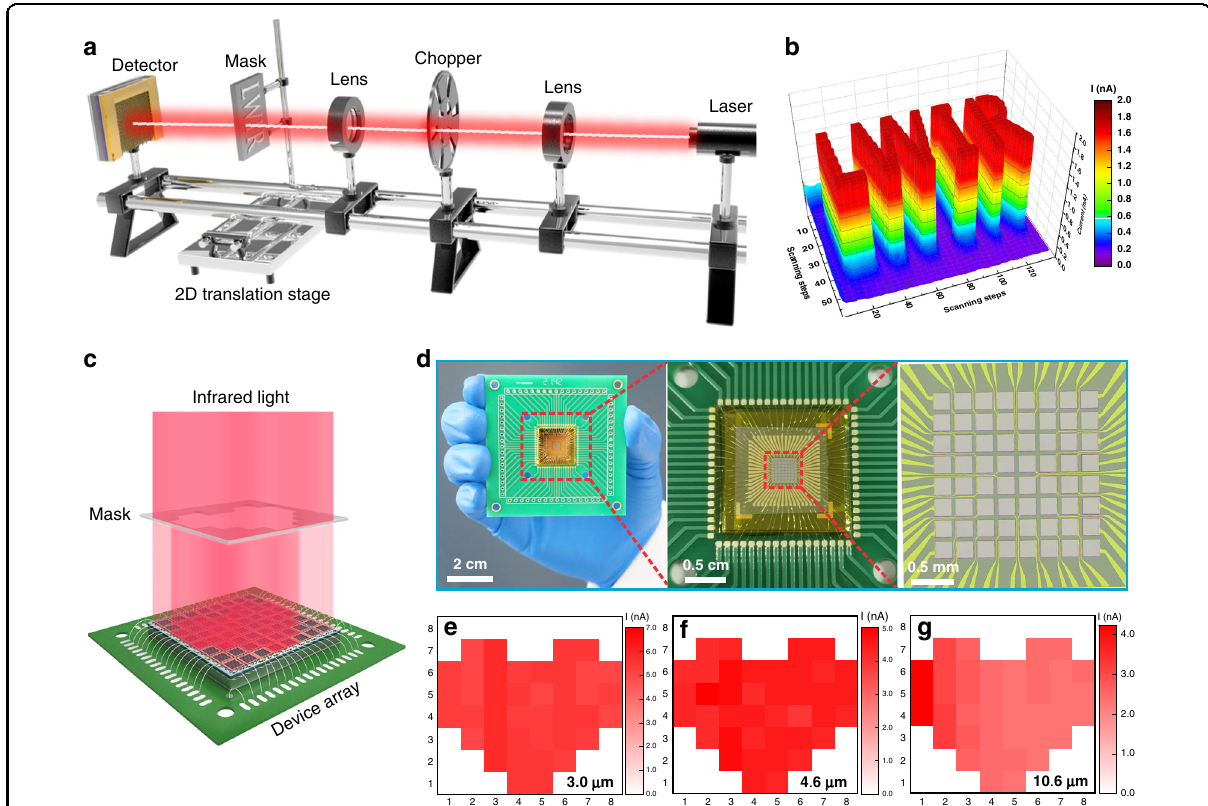
Fig. 6 MIR imaging application of the photodetector. a A schematic of a single-pixel-based IR imaging system. b IR imaging of “ LWIR ” patterns under 10.6 μ m at room temperature. c A schematic of IR imaging measurement based on devices array. d Photographs of an 8 × 8 1T ʹ -MoTe 2 /Si Schottky junction device array. The device area of each pixel cell is 200 × 200 μ m 2 . e – g The imaging results of the “ heart ” pattern under 3.0, 4.6, and 10.6 μ m,